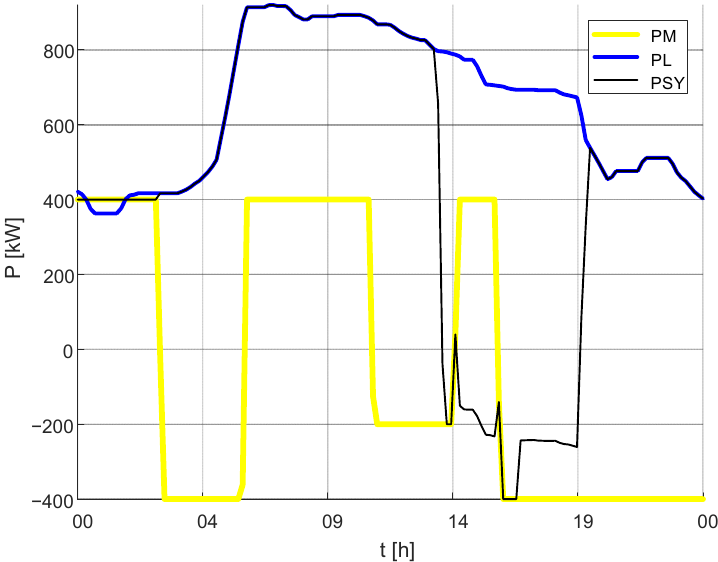
Figure 21. Results of the simulation of the operation of the private network with the BESS with real characteristics for the power margin PM set as a step function between − 400 and 400 kW; PSY—exchange power with the distribution grid and PL—load.